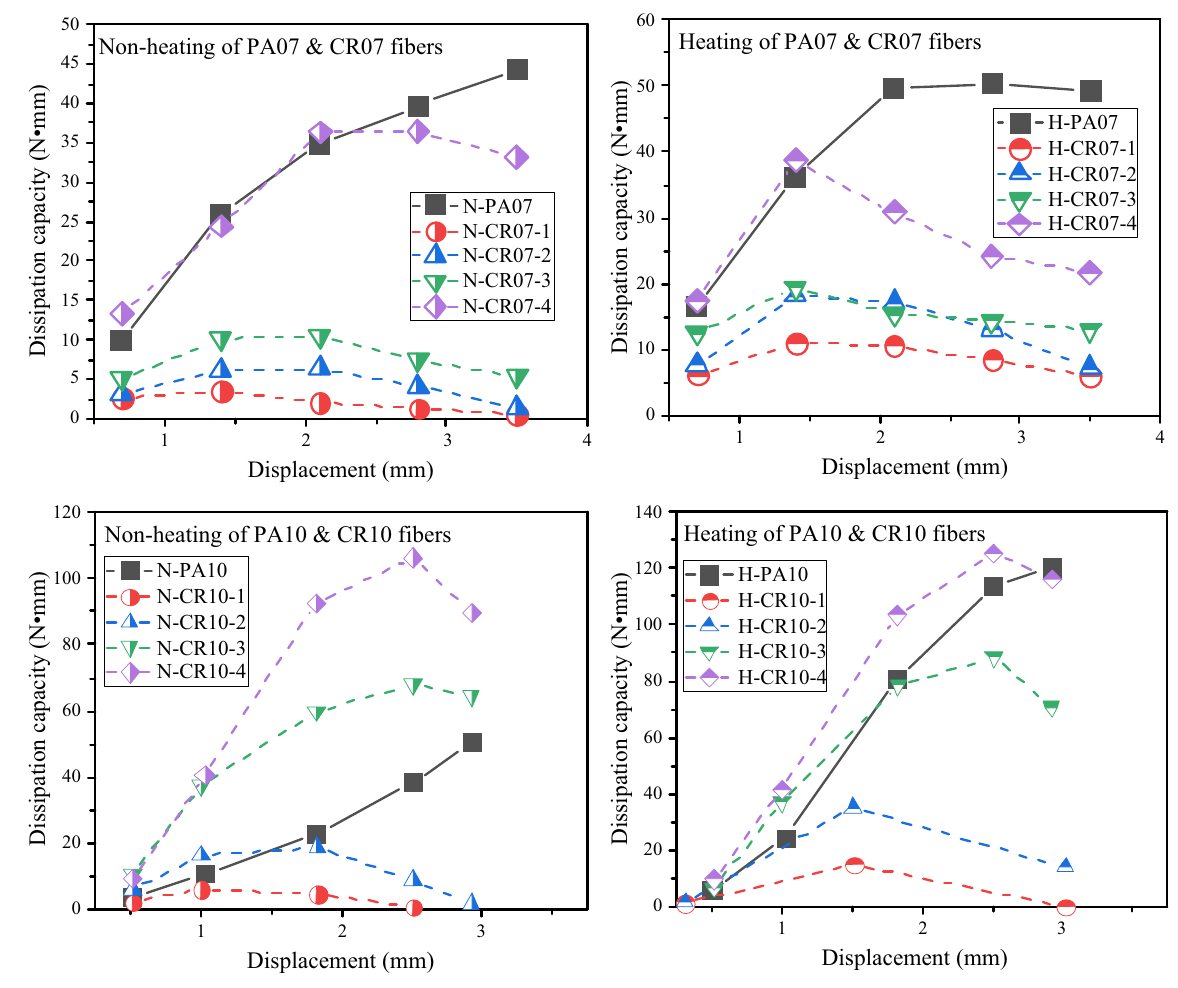
Figure 10: EDs of paddled and crimped fi bers with and without